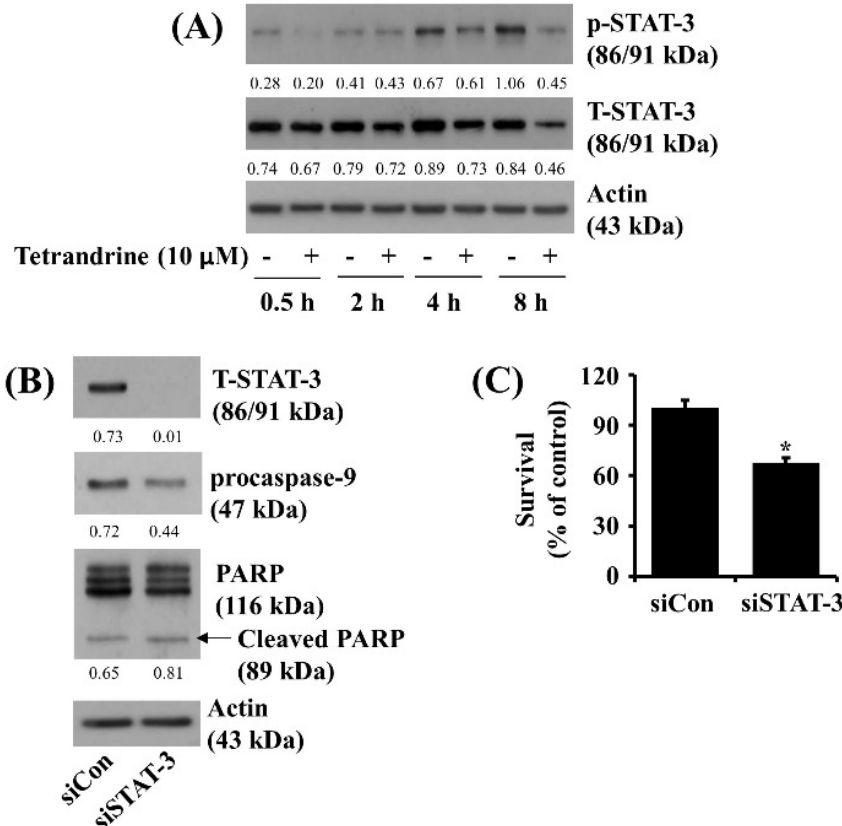
Figure 5. Effects of tetrandrine or knockdown of STAT-3 on the phosphorylation and expression levels of STAT-3, cell survival, procaspase-9, and PARP in SW872 cells. ( A ) SW872 cells were treated with vehicle control (0.1% DMSO) or tetrandrine at 10 µ M for the designated time point. Whole-cell lysates from the conditioned cells were prepared and analyzed for measurement of the expression of p-STAT-3, STAT-3, or β -actin by Western blotting. p-STAT-3, phospho-STAT-3; T-STAT-3, total STAT-3. ( B ) SW872 cells were transfected with siRNA (siCon) and STAT-3 siRNA (siSTAT-3) for 24 h.